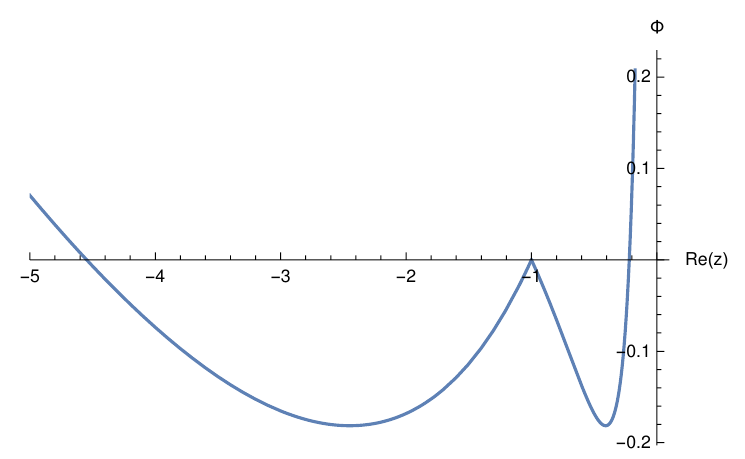
Figure 8. E(cid:11)ective potential (cid:8)( z ) along the negative real z -axis for g = 0 :